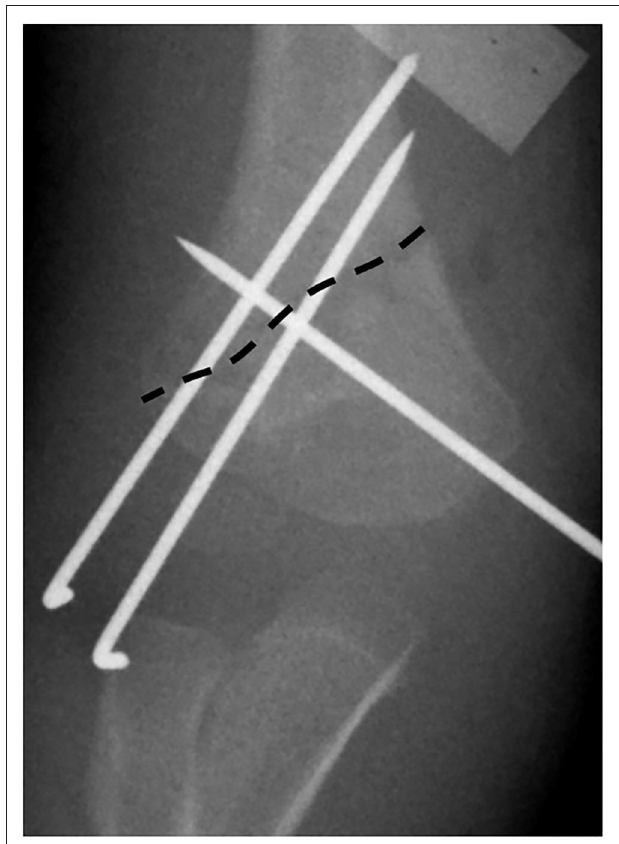
FIGURE 3 | The dashed line shows the fracture line. Cross-pin fixation was possible in this medial high-long oblique supracondylar humeral fracture; however, one lateral wire could not get the capitellar entry. Another pin was convergent due to the medial high fracture line.